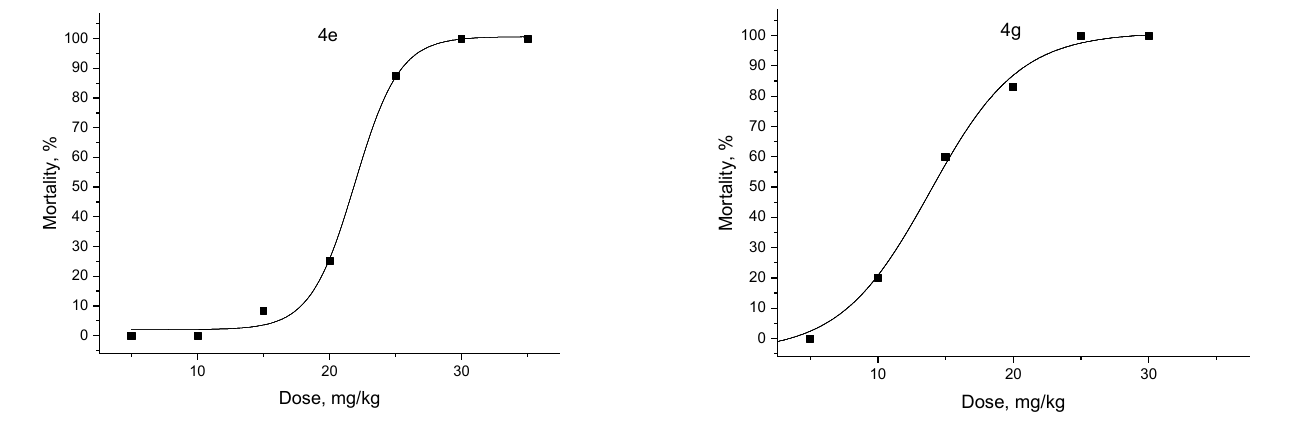
Figure 9. Dose-response curves for single intraperitoneal administration of 4e and 4g to BDF 1 hybrid mice. Table 5. Acute toxicity parameters of compounds 4e and 4g after intraperitoneal administration.